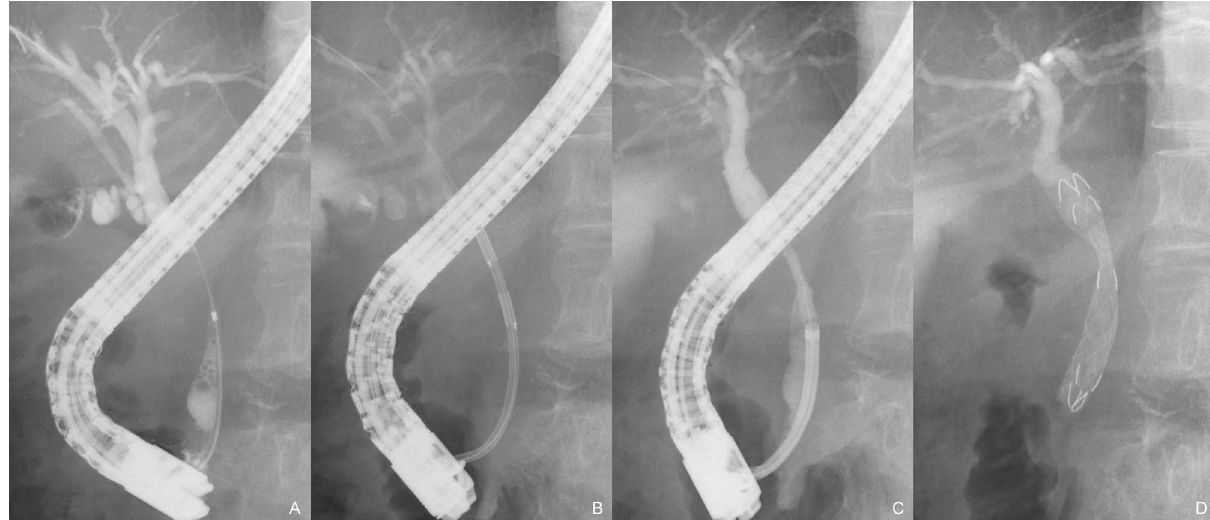
Figure 2. Severe stricture of the distal bile duct ( A ). Ablation of the stricture was performed ( B ), which improved the stricture diameter ( C ). A double bare stent is subsequently placed to cover the stricture ( D